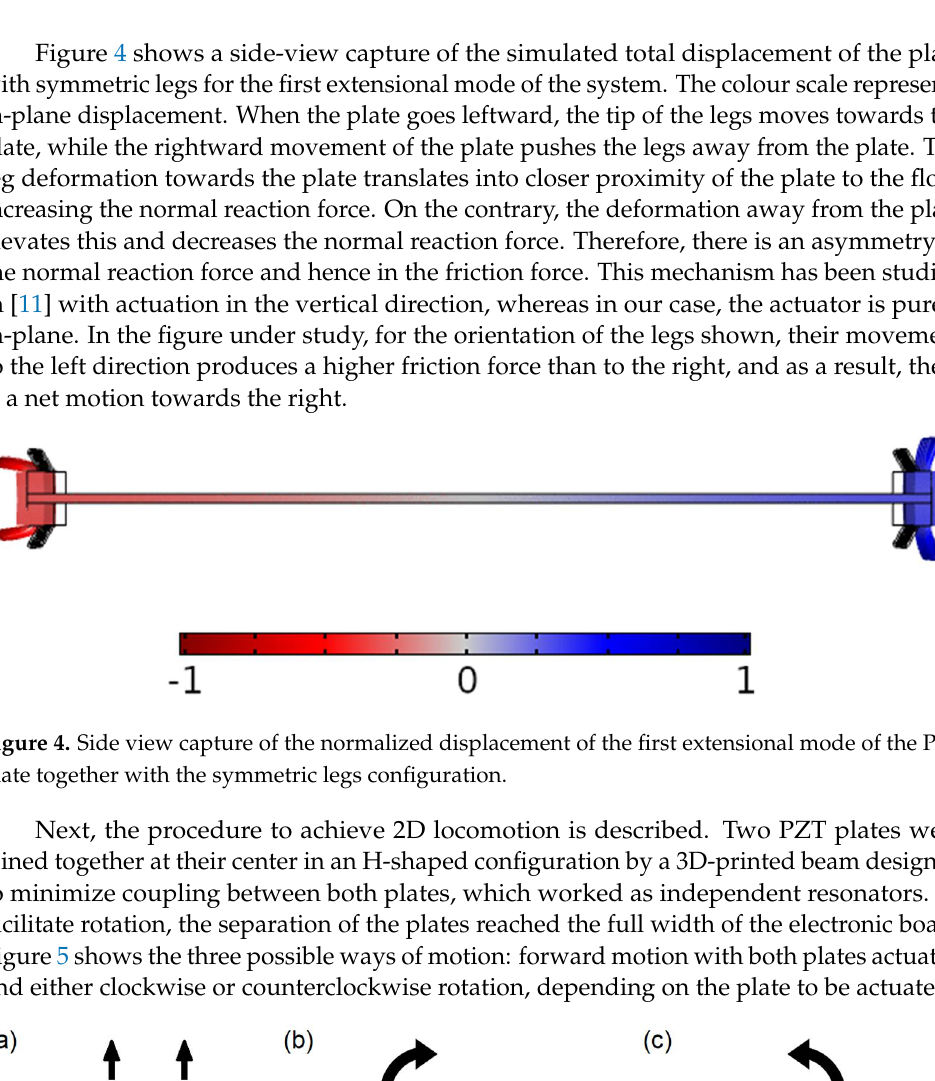
Figure 3. Top view and 3D view of the in-plane and out-of-plane normalized displacements of the first extensional mode of the PZT plate with ( a ) legs attached at the bottom and ( b ) legs attached at both the top and the bottom of the plate.